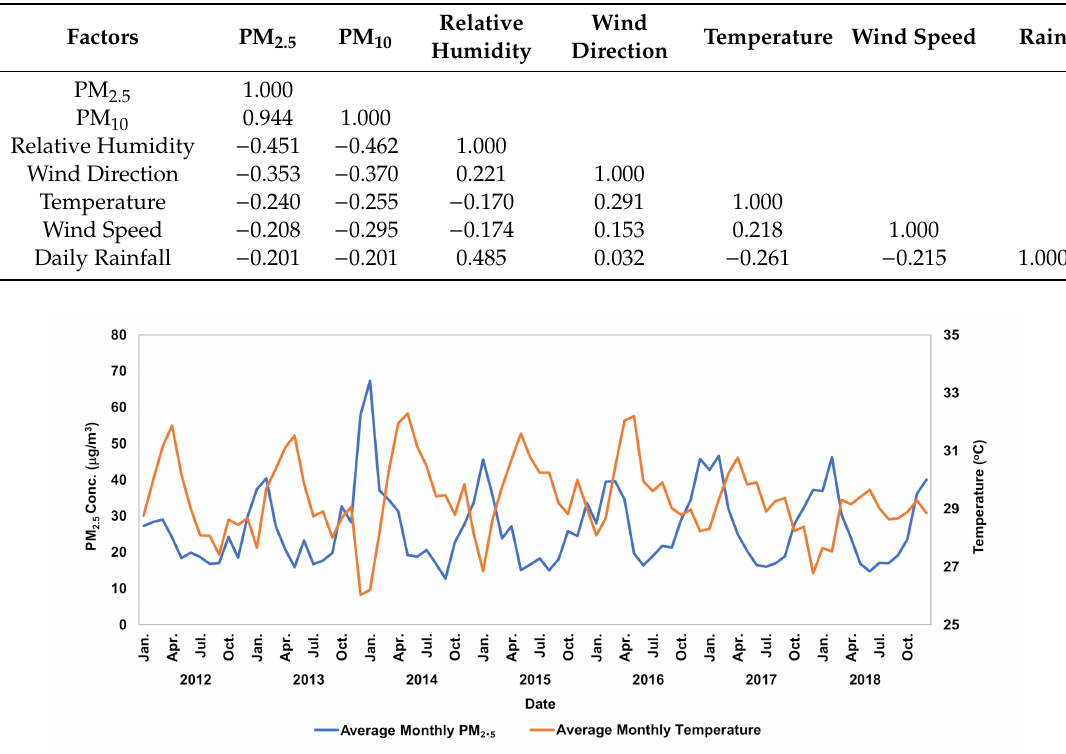
Table 3. Pearson correlations coe ffi cient between particulate matter and meteorological factors.